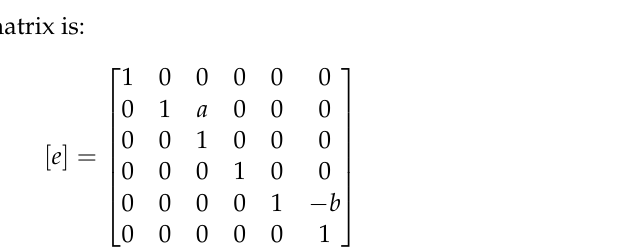
Figure 10. The beam with rigid zones at the ends.